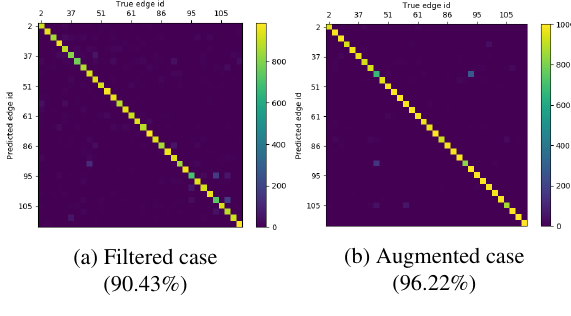
Figure 12. Confusion matrix